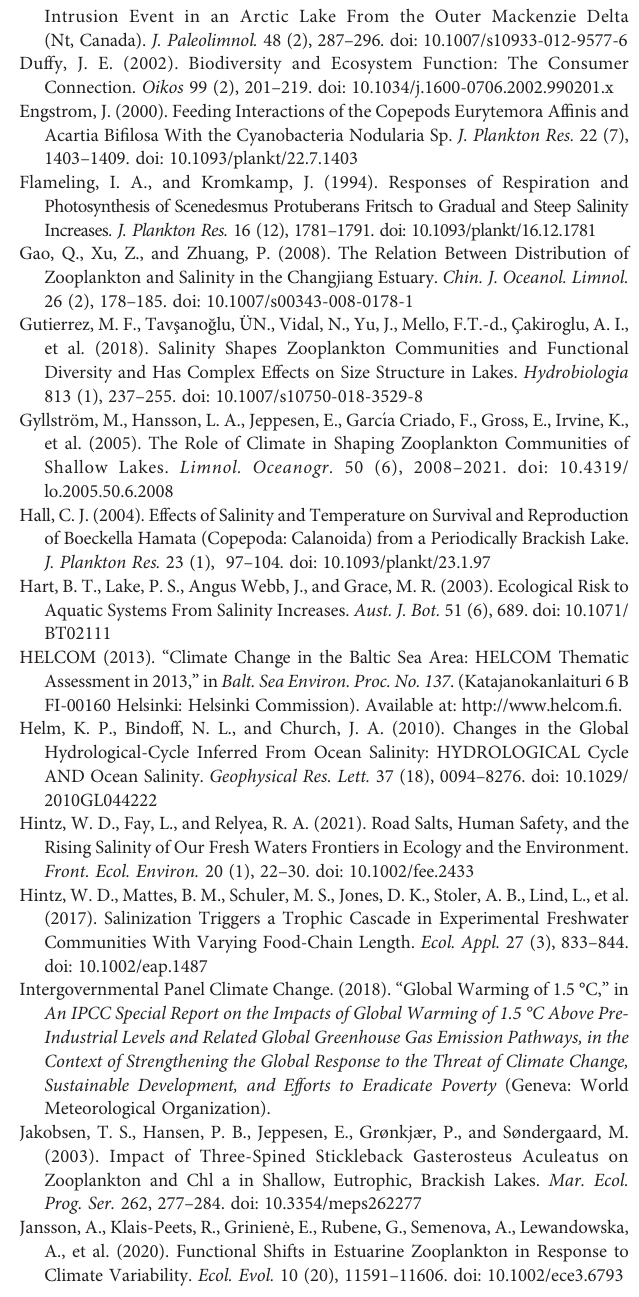
Supplementary Figure 1 | Zooplankton abundance with salinity treatment over time for all zooplankton groups. Rare species excluded from analysis are not shown. Statistical tests were performed as described in the main text, methods